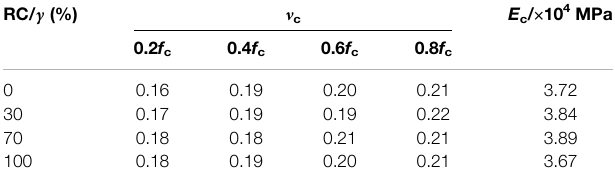
TABLE 5 | Measured Poisson ’ s ratios and elasticity modulus of